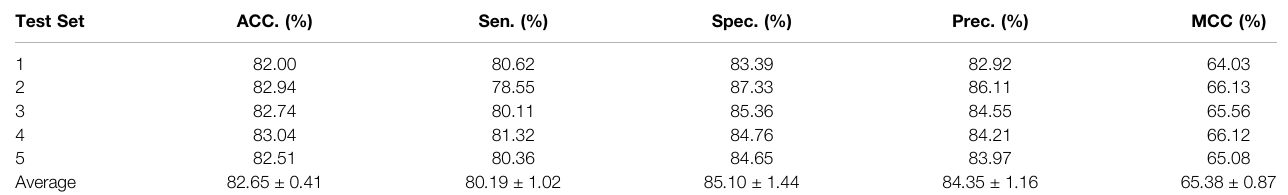
TABLE 1 | Five-fold cross-validation results performed by KGDCMI. Test Set